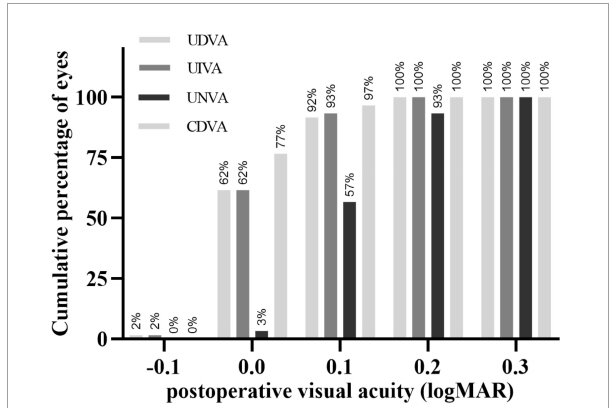
FIGURE1 Cumulative percentage of eyes that achieved a cumulative value of monocular uncorrected distance (5 m), intermediate (80 cm), and near (40 cm) visual acuity, and corrected-distance visual acuity in logarithmic units. UDVA, uncorrected distance visual acuity; UIVA,